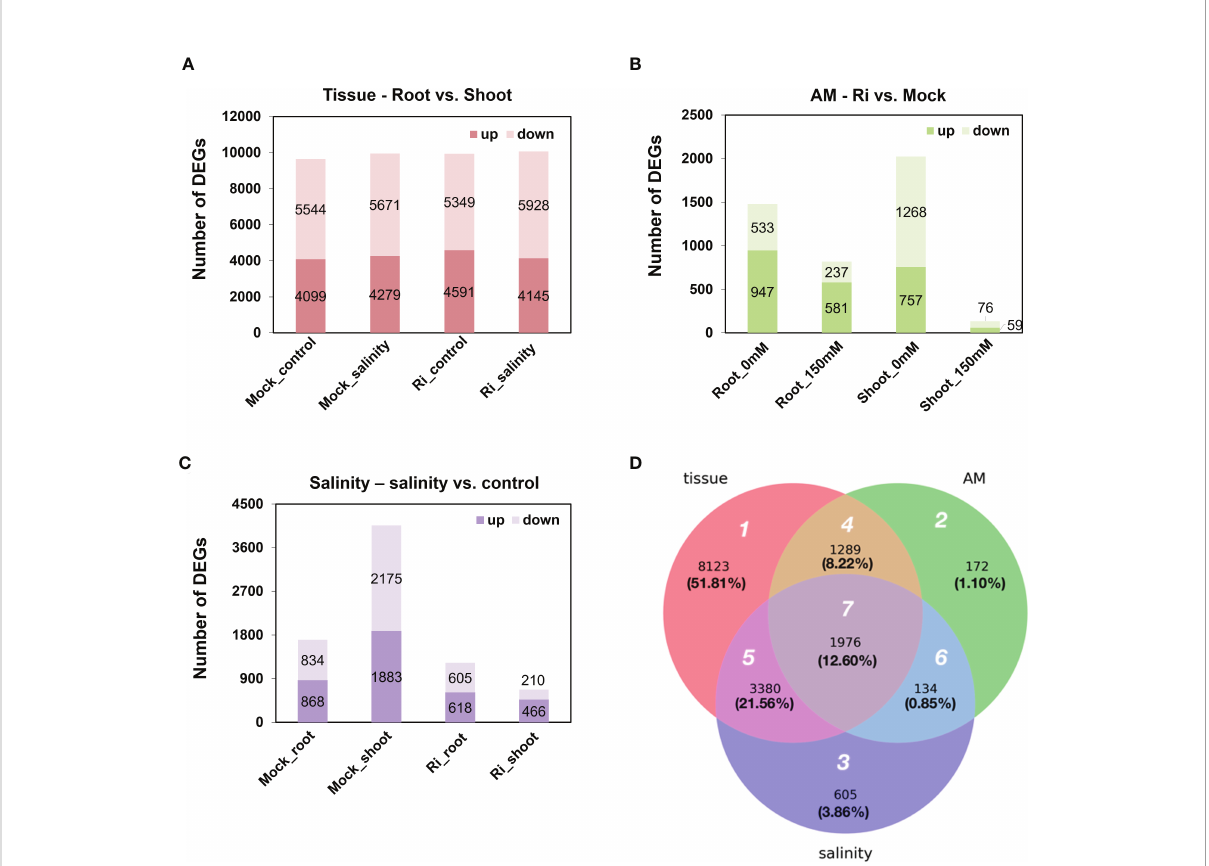
FIGURE 3 Differentially expressed genes (DEGs) regulated by tissue, AM symbiosis, and salinity stress (A) The number of up- and downregulated DEGs in roots compared to shoots. Upregulated referred to higher expression in roots compared to shoots and vice versa. (B) The number of up- and downregulated DEGs by AM symbiosis. Upregulated referred to higher expression in mycorrhizal (Ri) tissues than mock tissues and vice versa. (C) The number of up- and downregulated DEGs by salinity. Upregulated referred to higher expression in tissues grown under salinity conditions (150 mM) than under control conditions (0 mM) and vice versa. A total of 8 groups of samples were pairwise compared to identify DEGs regulated by tissue, AM symbiosis or salinity with cutoffs o fl og 2 (fold-change)> 1 and FDR < 0.05. (D) Venn diagram showing the overlap of DEGs among the three treatment groups. White number: region number; black number: number of DEGs; black number inside parenthesis, percentage of the total